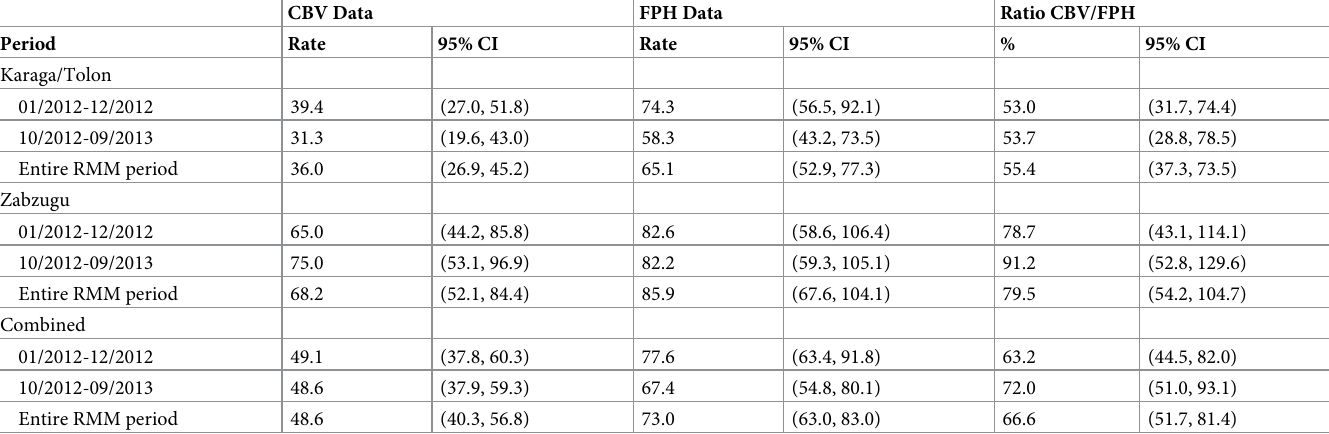
Table 4. Under-five mortality rates estimated from CBV records and FPH data and corresponding 95% confidence intervals.